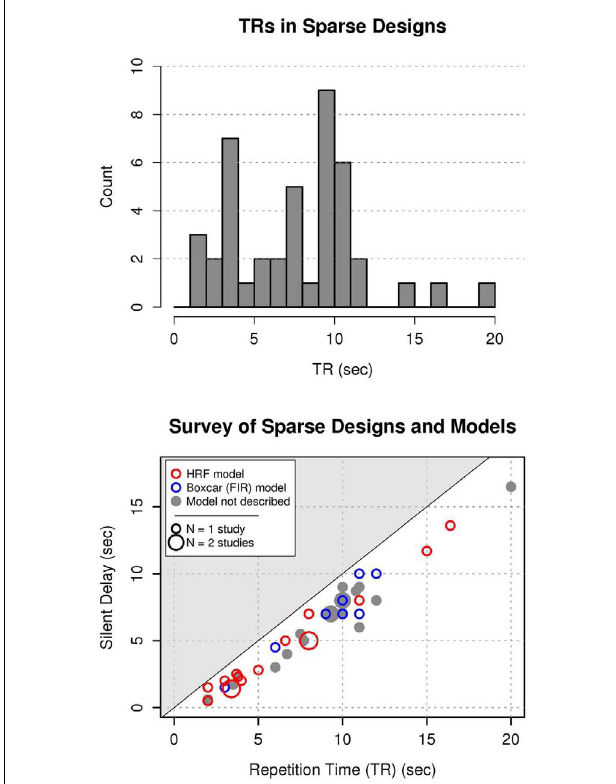
FIGURE 1 | Survey of contemporary sparse-sampling fMRI design and analysis methods. Top panel: of papers published in 2011, two principal modes of sparse design were observed – those involving shortTRs ( ≤ 4s), and those involving longTRs (9–12s), with comparatively fewer using intermediate values. Bottom panel: choice of sparse analysis model across designs. Red outlined circles = Models employing HRF convolution; Blue outlined circles = Boxcar (FIR) models; Filled gray circles = studies with no description of the model basis functions. Smaller circles are N = 1 study at that point, larger circles are N = 2 studies. Continuous sampling studies would lie on the line y = x .The silent delay cannot exceed theTR (shaded region;TR = TA + silent